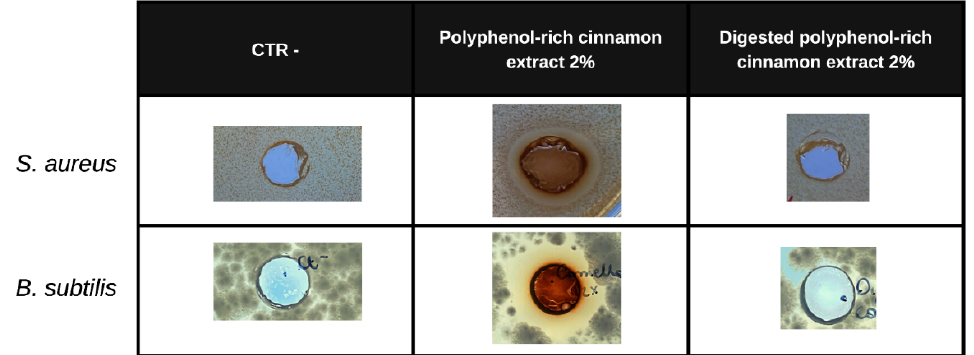
Figure 3. Antimicrobial activity of polyphenol-rich cinnamon bark extract before and after in vitro digestion. The figure represents only the positive results of the AWDA conducted with the polyphenol-rich cinnamon bark extract and the in vitro digested polyphenol-rich cinnamon bark extract (after oral, gastric, and intestinal phases) at 2% w/v . The positive results are growth inhibition haloes, as depicted in the column “polyphenol-rich cinnamon extract 2%”, indicating the sensitivity of S. aureus and B. subtilis to the natural extract. “CTR-” is the negative control showing no inhibition halo; “digested polyphenol-rich cinnamon extract 2%” is the digested form of the extract, showing no inhibition halo.